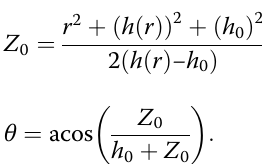
Since this is valid for all points on the β phase in the model, the average value is uti- lised to reduce numerical noise and obtain a single value for comparison. Note that this